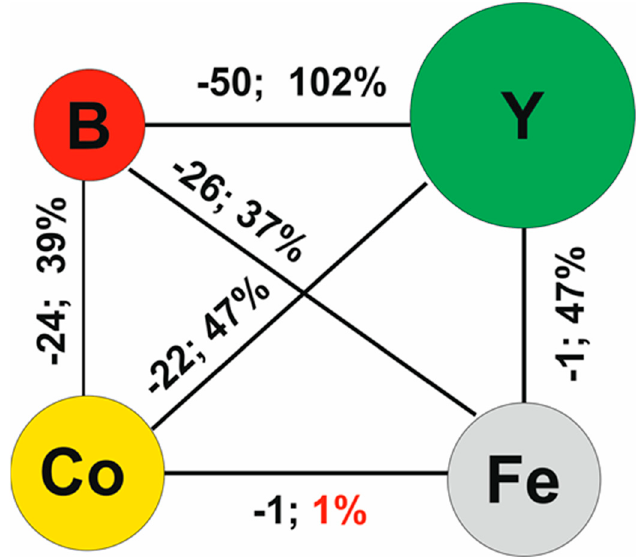
Figure 2. Diagram of mixing heats and the di ff erences in the lengths of atomic radii of the alloying elements.